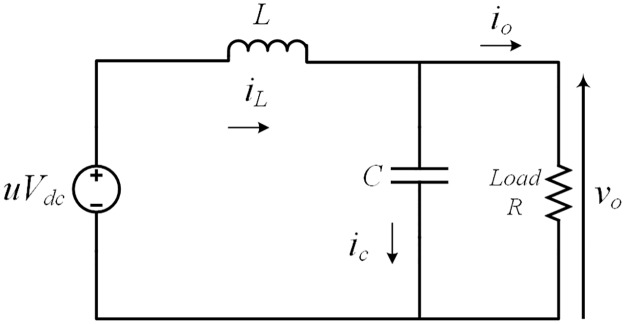
Equivalent circuit.